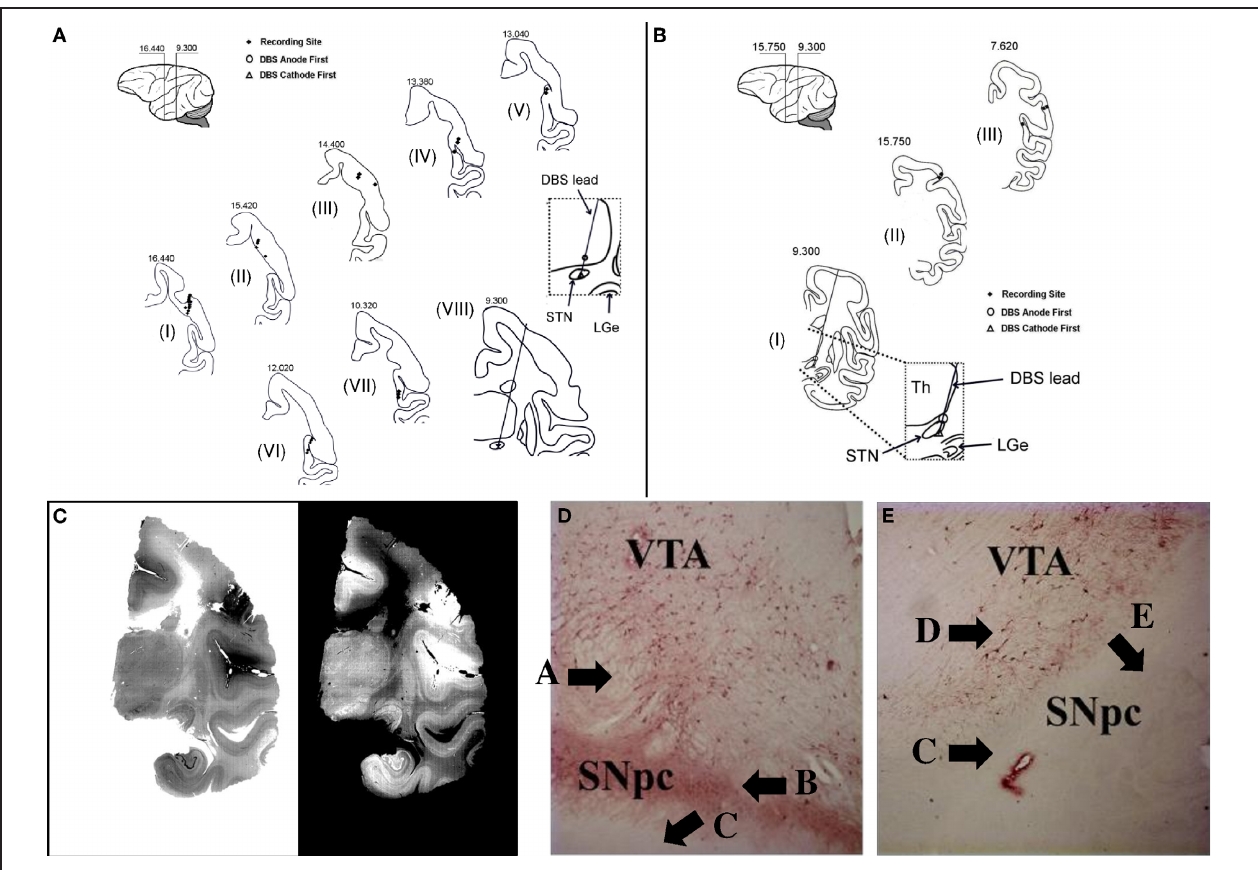
determined (animal A, section VIII). (D,E) Example of section through the ipsilateral (D) and contralateral (E) substantia nigra pars compacta (SNpc) and ventral anterior thalamus (VTA) stained with TH antibodies after unilateral intracarotid injection of MPTP (animal A). See Results for explanation of labels